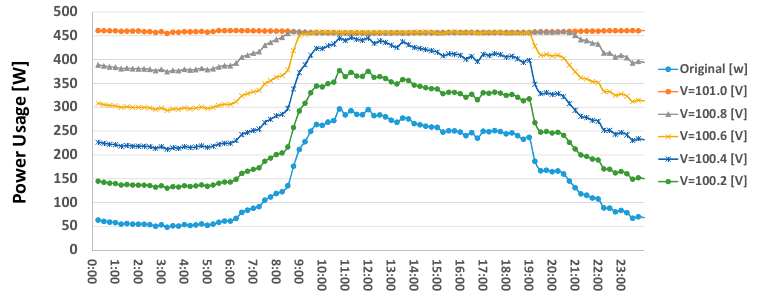
Figure 13. Estimation error of missing readings in initial part with respect to the error in the estimated voltage at the pole-transformer.